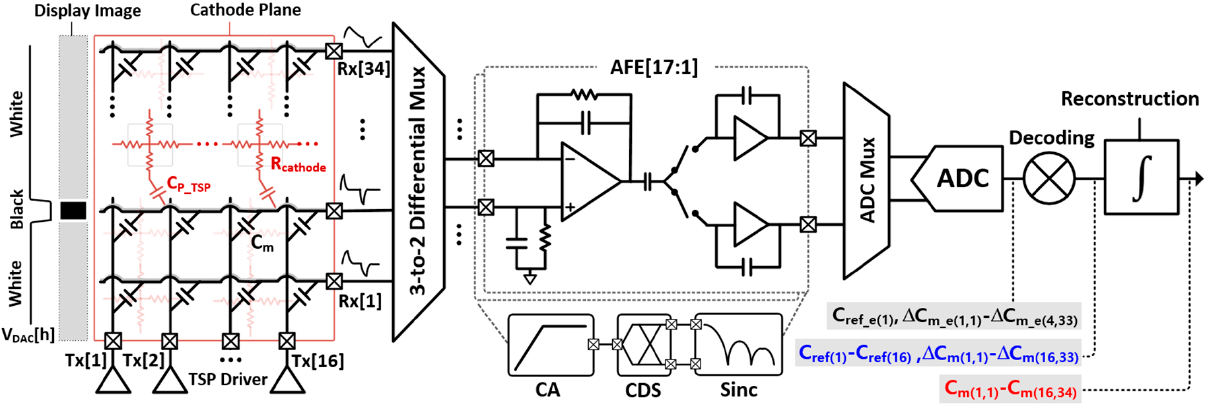
Figure 7. Proposed MRDS front-end